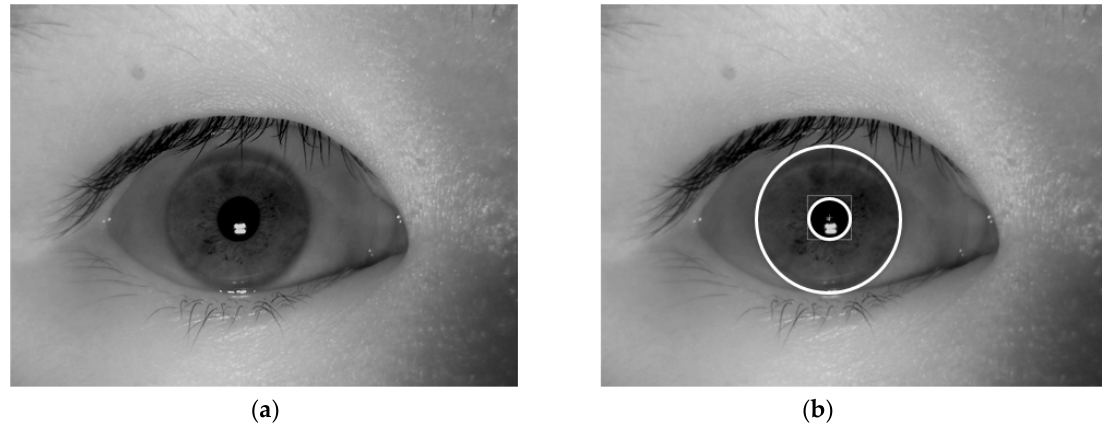
Figure 2. Examples of detection result of iris detection method: ( a ) a near-infrared (NIR) iris image, and ( b ) detection result of the NIR iris image in ( a ).